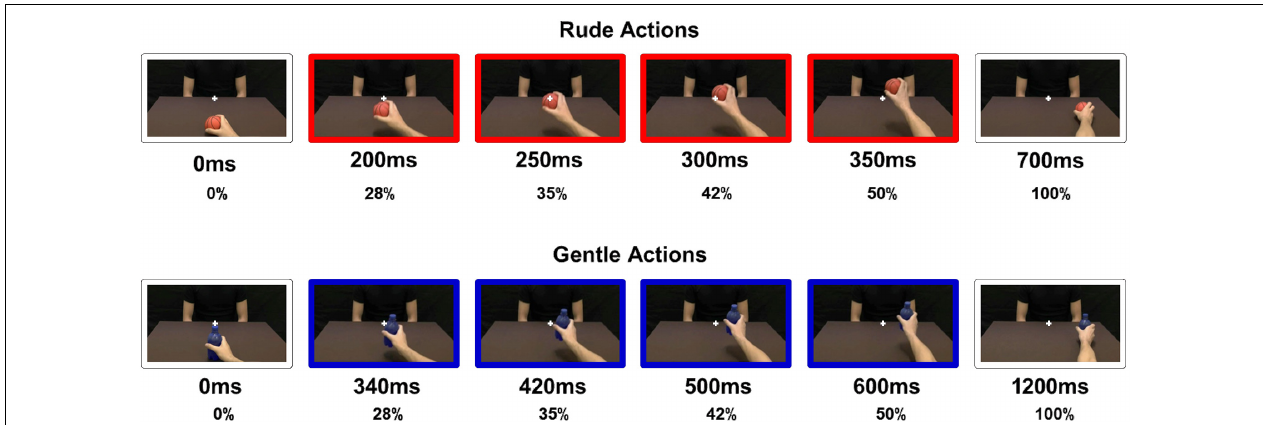
FIGURE 1 | Video stimuli presented to participants. For rude actions (red color): 200, 250, 300, or 350 ms, corresponding to 28, 35, 42, and 50%, respectively, of the total duration (700 ms). For gentle actions (blue color): 340, 420, 500, or 600 ms, corresponding to 28, 35, 42, and 50%, respectively, of the total duration (1,200